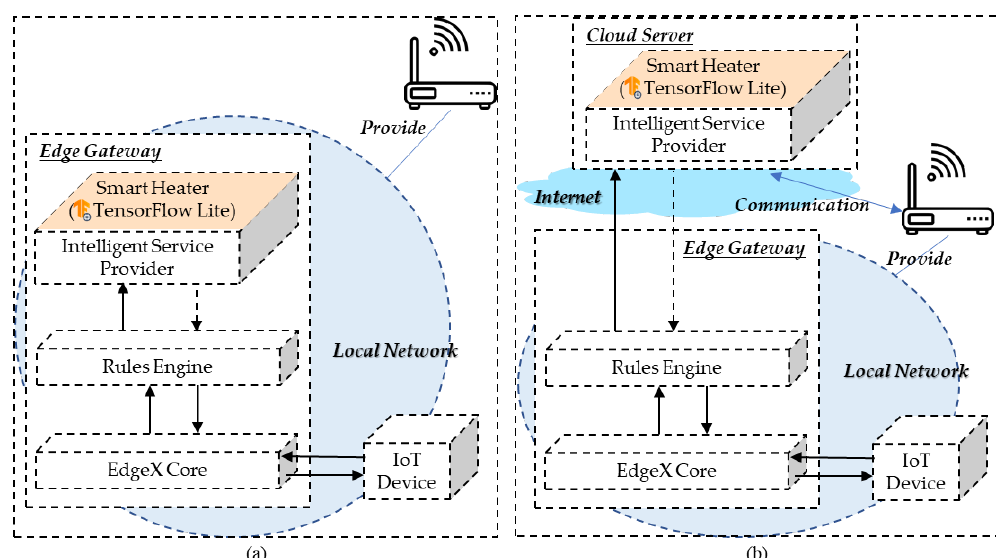
Figure 16. Network architecture for experimenting internal and external intelligent functions. ( a ) Internal intelligent function. ( b ) External intelligent function.